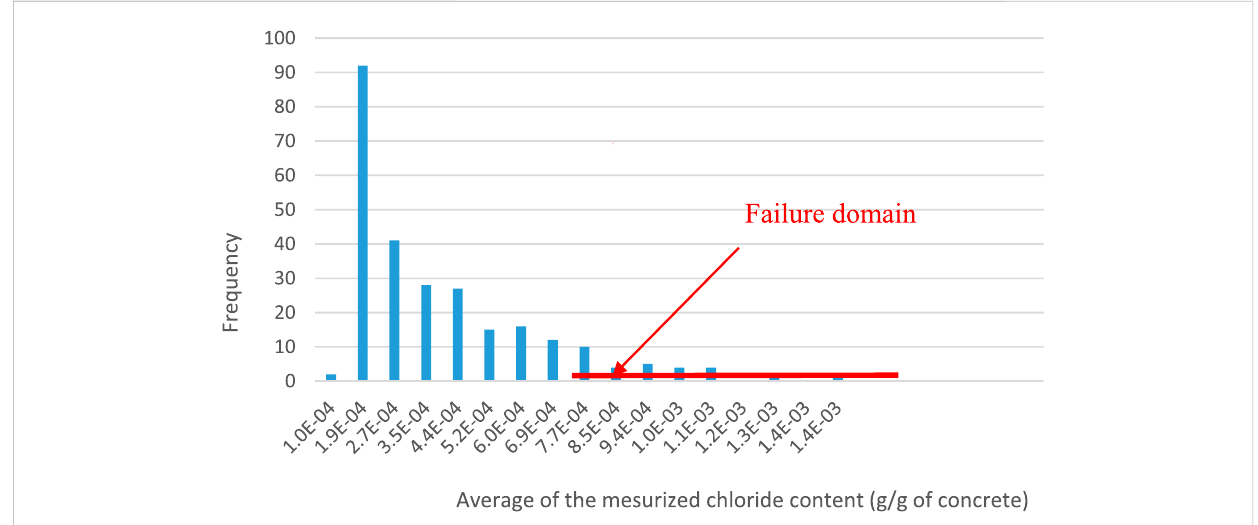
FIGURE 8 Presentation of the failure zone for average chloride contents.